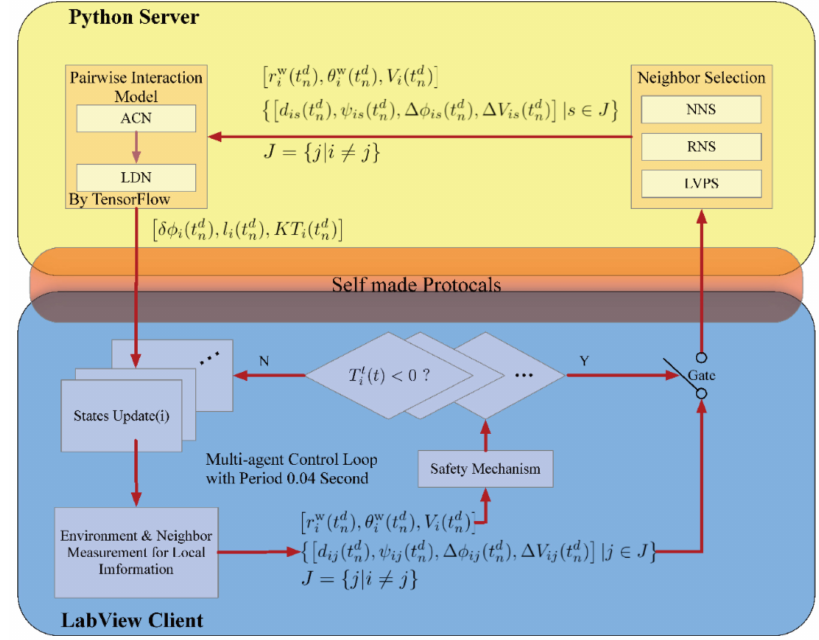
Figure 5. The structure of the simulation